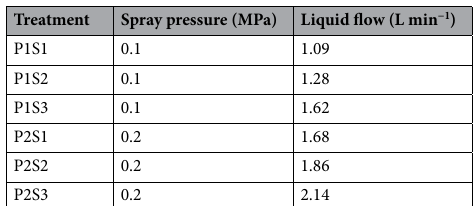
Table 4. The treatment selected in the spray test and its corresponding spray pressure and liquid